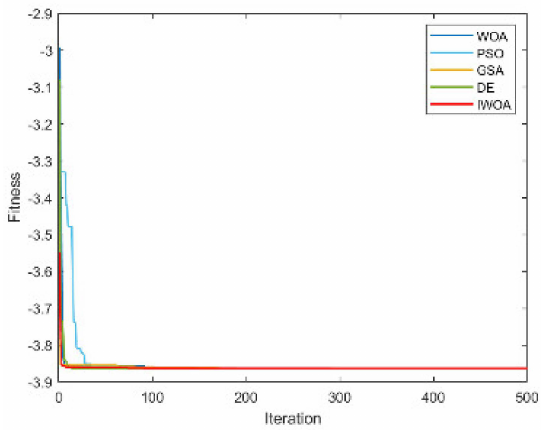
Figure A12. The convergence curve for solving F12.